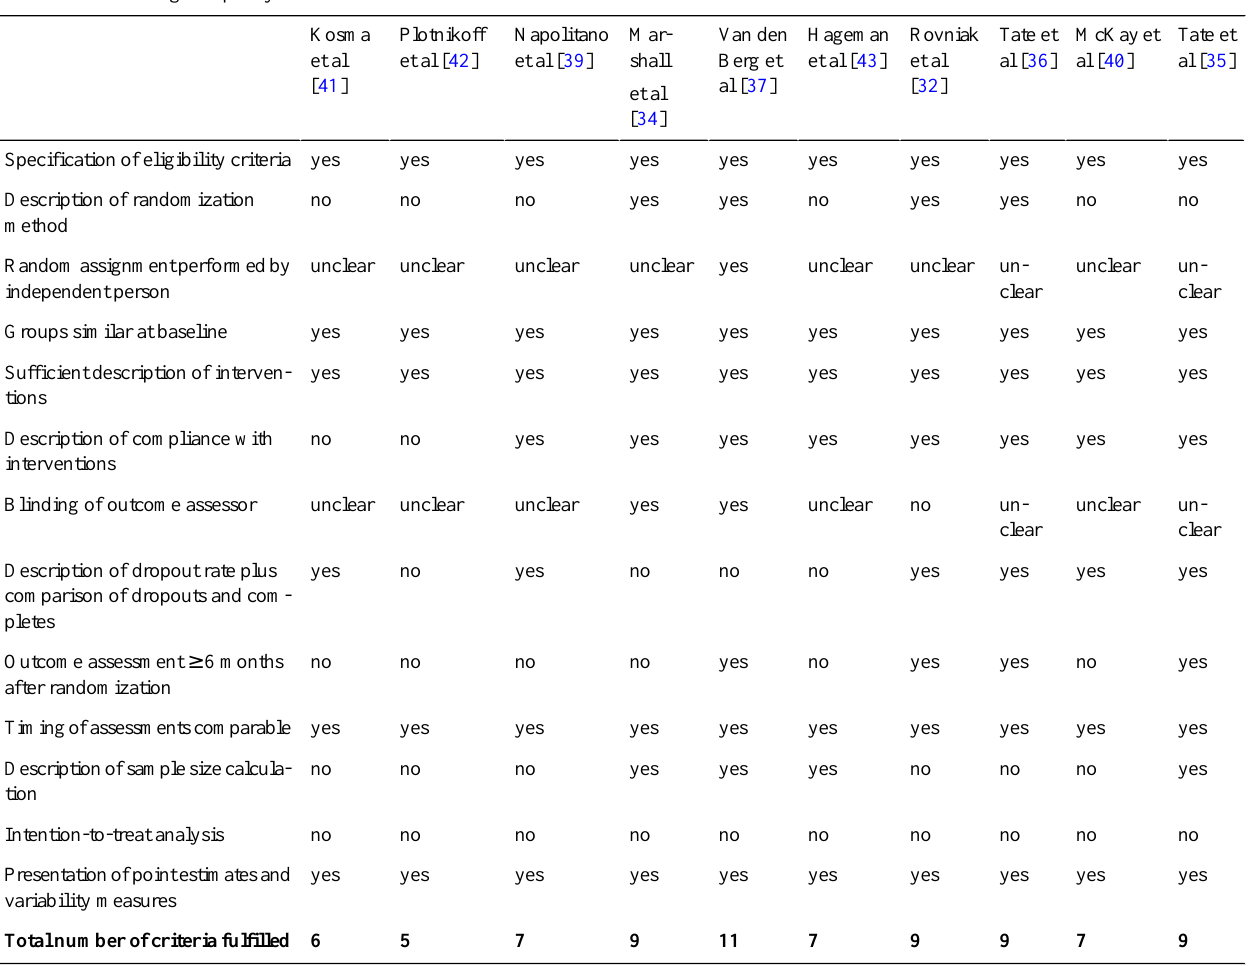
Table 1. Methodological quality of the studies